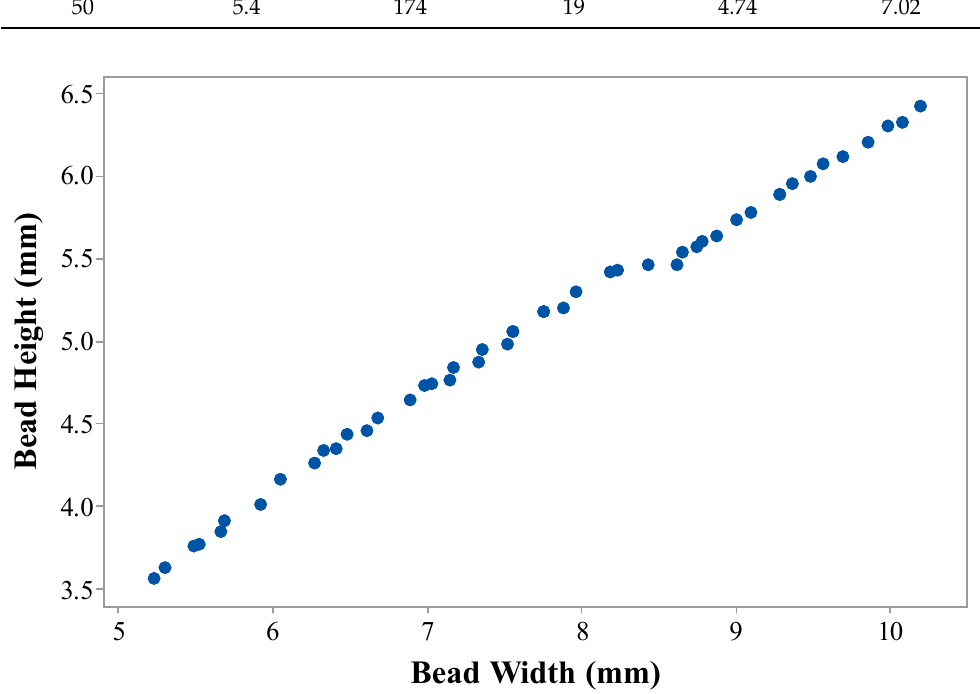
Figure 9. Pareto graph for bead height vs. bead width.